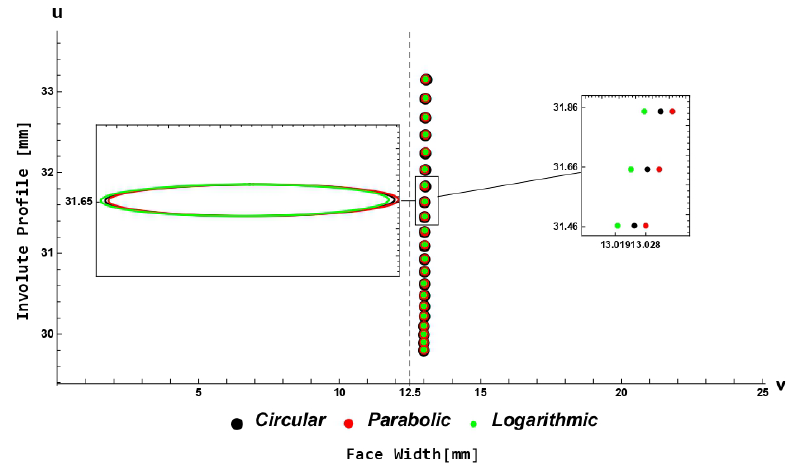
Figure 12. Path of contact of longitude circular, parabolic, and logarithmic crowned spur gear with 0.4° (7 mrad) of out-of-plane angular misalignment, where the scaled contact trajectories and the contact ellipses are shown. The dashed line is the center of the tooth surface along gear width.